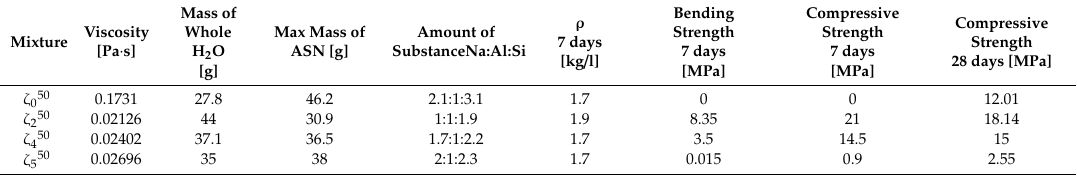
Table 12. Density, bending, and compressive strength of AAM prepared with same amount of liquid phase and di ff erent amount of substance ratios of first group, Al and Si, cured on 70 ◦ C for one day, measured one week after molding, and compressive strength four weeks after molding. Combination of ingredients for AA resulting in literature’s highest compressive strength value is